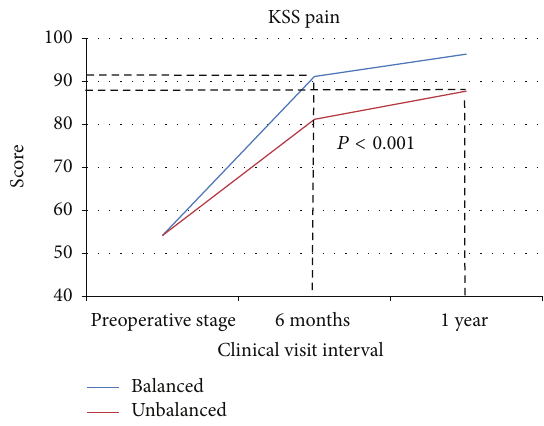
Figure 2: The lines represent the KSS pain scores for the balanced and unbalanced patients from preoperative stage to 1 year. The dashed lines indicate the disparity between the balanced and unbalanced patients’ pain scores.